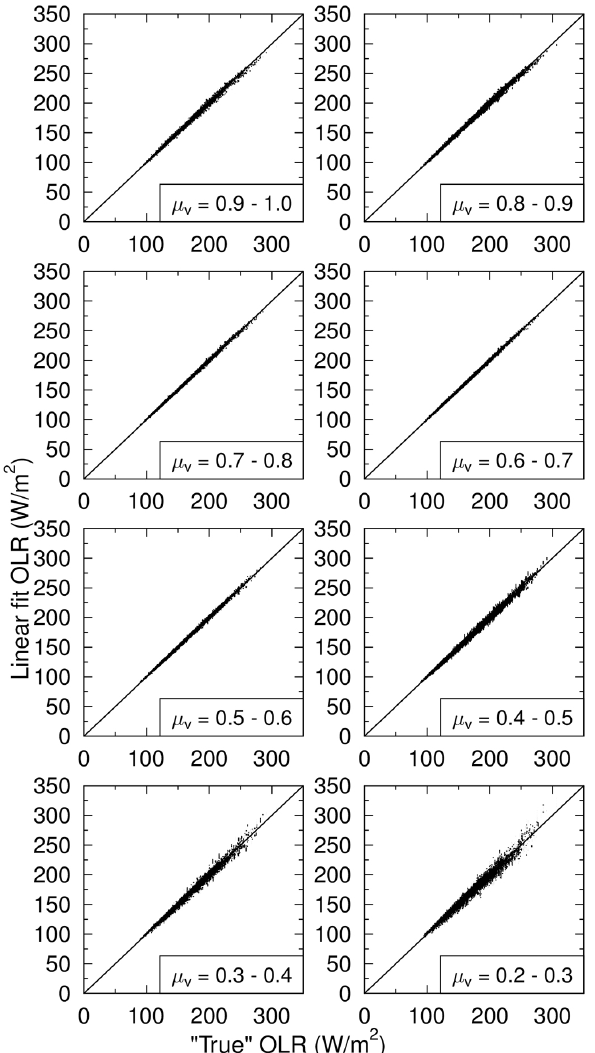
Fig. 3. Same as Fig. 2, but for cases with cirrus clouds and split into several viewing angle